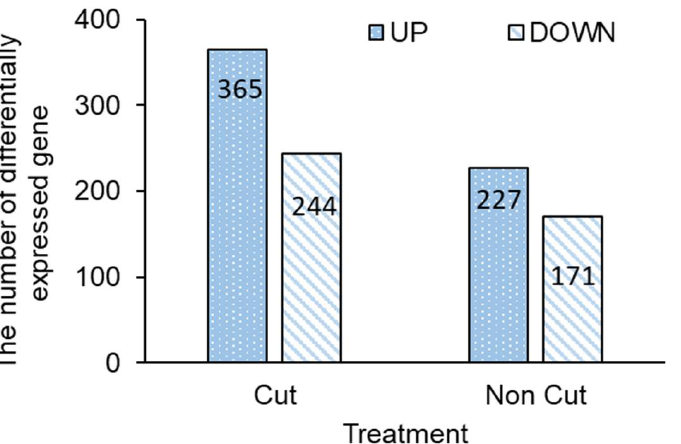
Figure 4. Total numbers of differentially upregulated and downregulated genes in canola subjected to UV irradiation with or without 300 nm short-cut filters. The UV-B irradiation intensity at the top of the cultivation panel was set to 0.6 W m −2 . The numbers of upregulated (Log2 fold change ≥ 1) and downregulated genes (Log2 fold change ≤ −1) are presented. Table 1. Gene expression variation related to phenylpropanoid and flavonoid biosynthesis in canola subjected to UV irradiation with or without 300 nm short-cut filters. Values indicate Log2 ratios ( n = 1) obtained by calculating treatment: control gene expression ratios. The UV-B irradiation intensity at the top of the cultivation panel was set to 0.6 W m −2 .